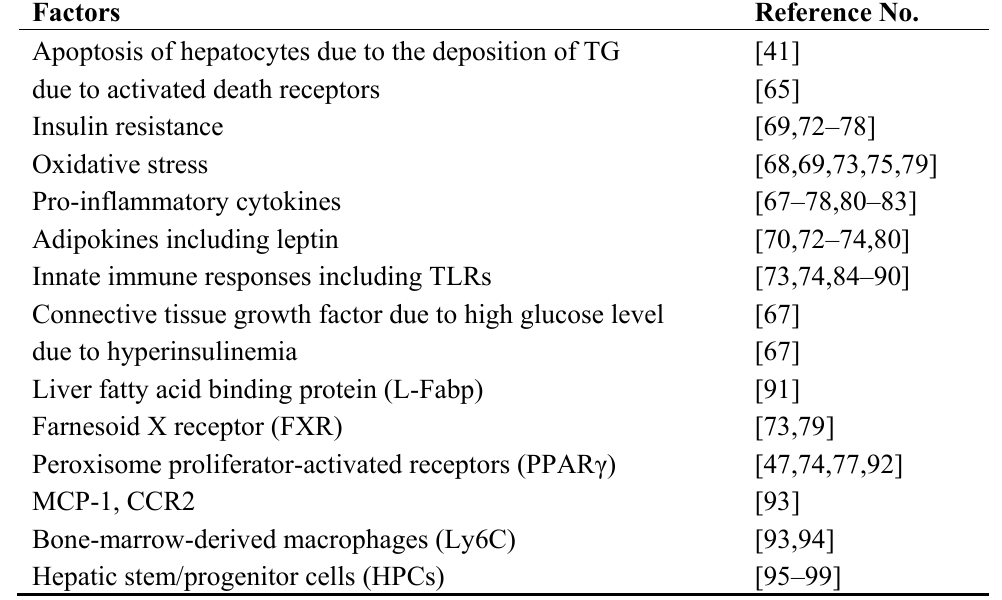
Table 1. Reported factors involved in fibrogenesis of